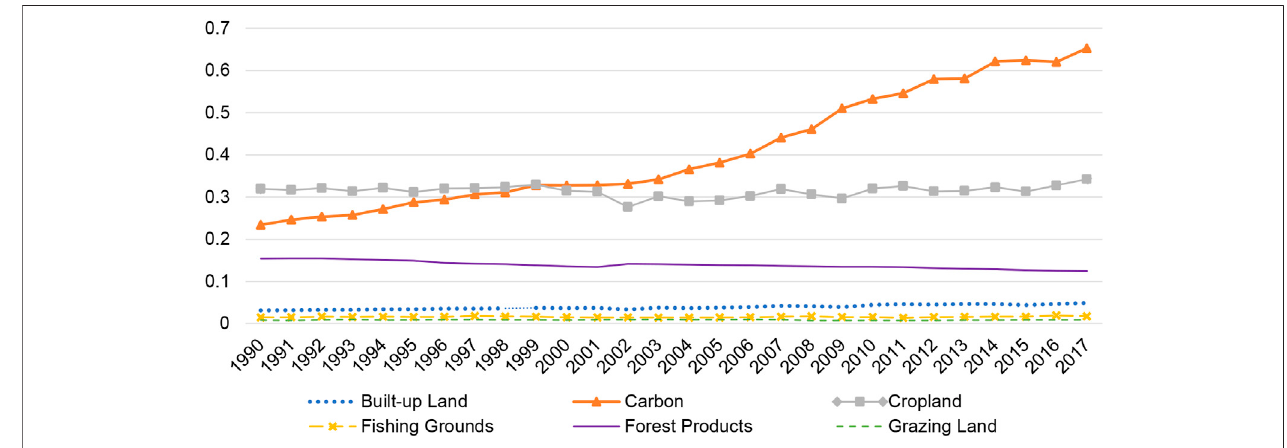
FIGURE 1 | The trends in crop-land, forest, grazing, fi shing, built-up land, and carbon footprint.